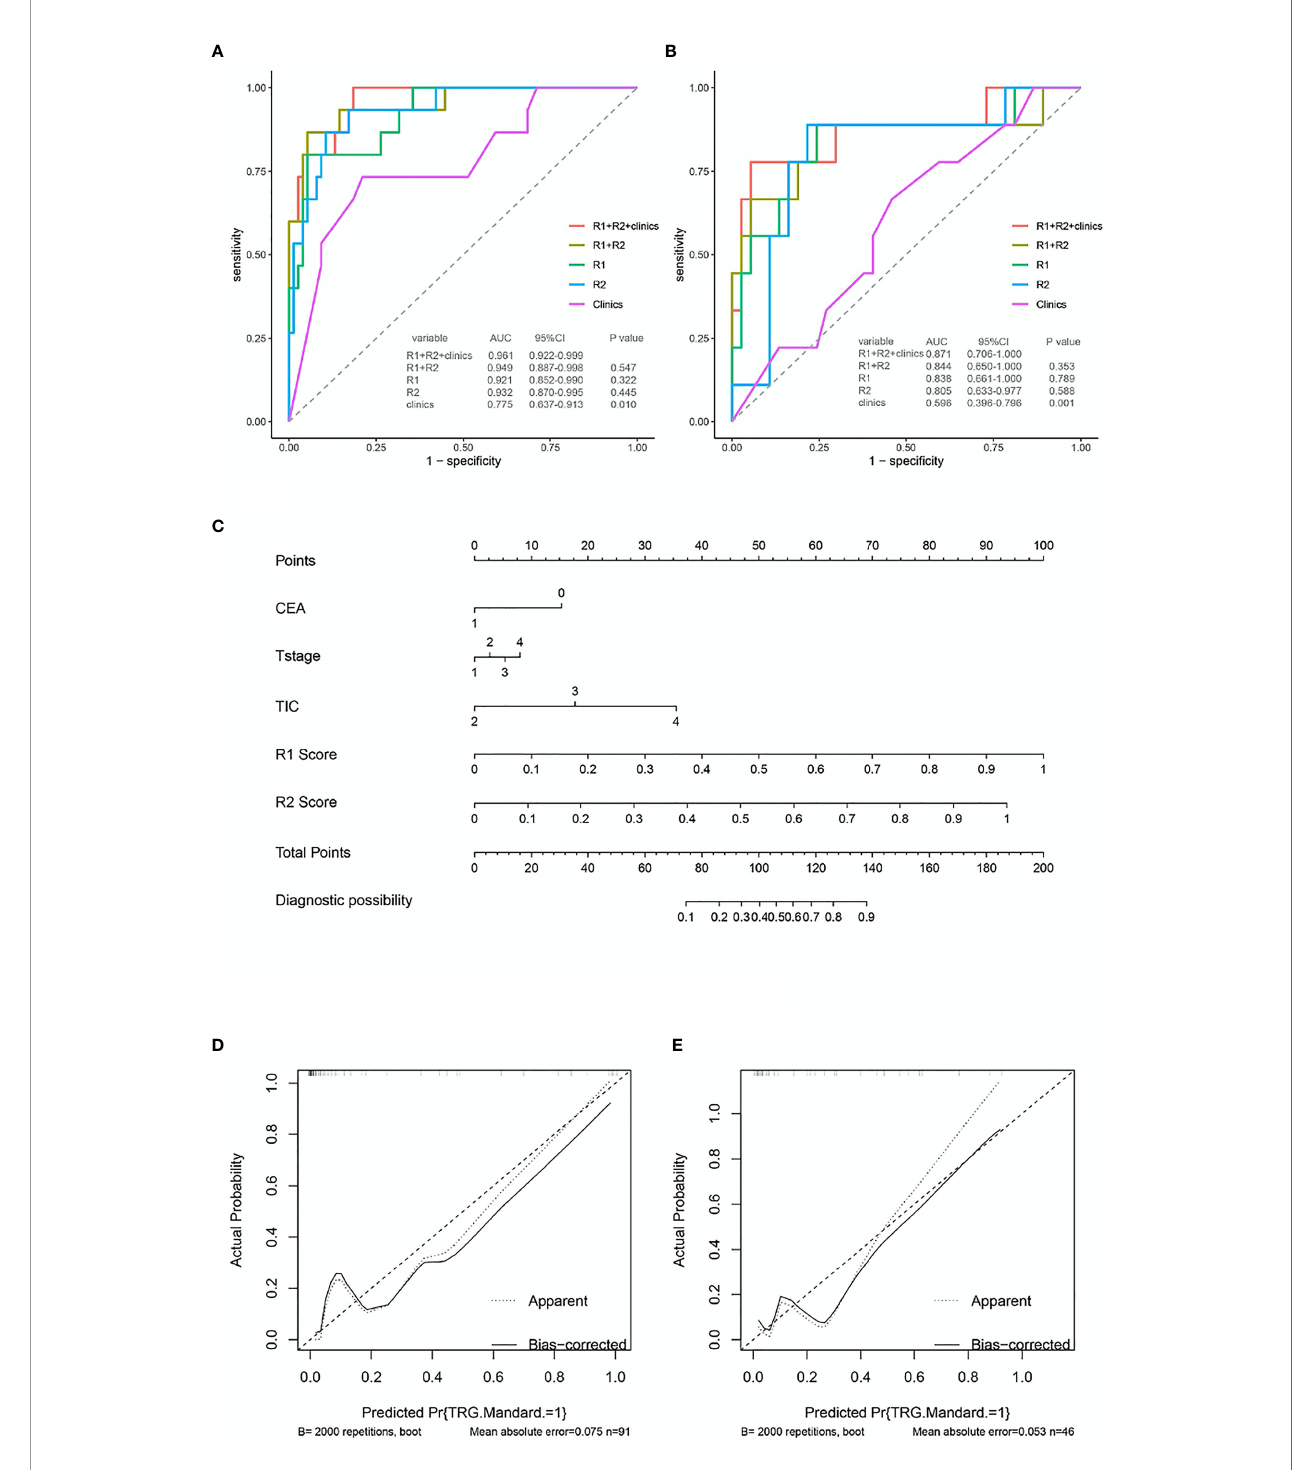
FIGURE 6 | ROC and nomogram based on the clinical characteristics and intra-peritumor radiomics features in the prediction of response to neoadjuvant chemotherapy in locally advanced rectal cancer (LARC). (A) The receiver operating characteristic curve (ROC) for different models in predicting treatment response for LARC in the training set. (B) The ROC for different models in predicting treatment response for LARC in the validation set. (C) Nomogram based on the clinical characteristics and combined-radiomics features in the prediction of response to neoadjuvant chemotherapy in locally advanced rectal cancer (LARC). (D, E) The calibration curve for the models in predicting treatment response for LARC in the training set and validation